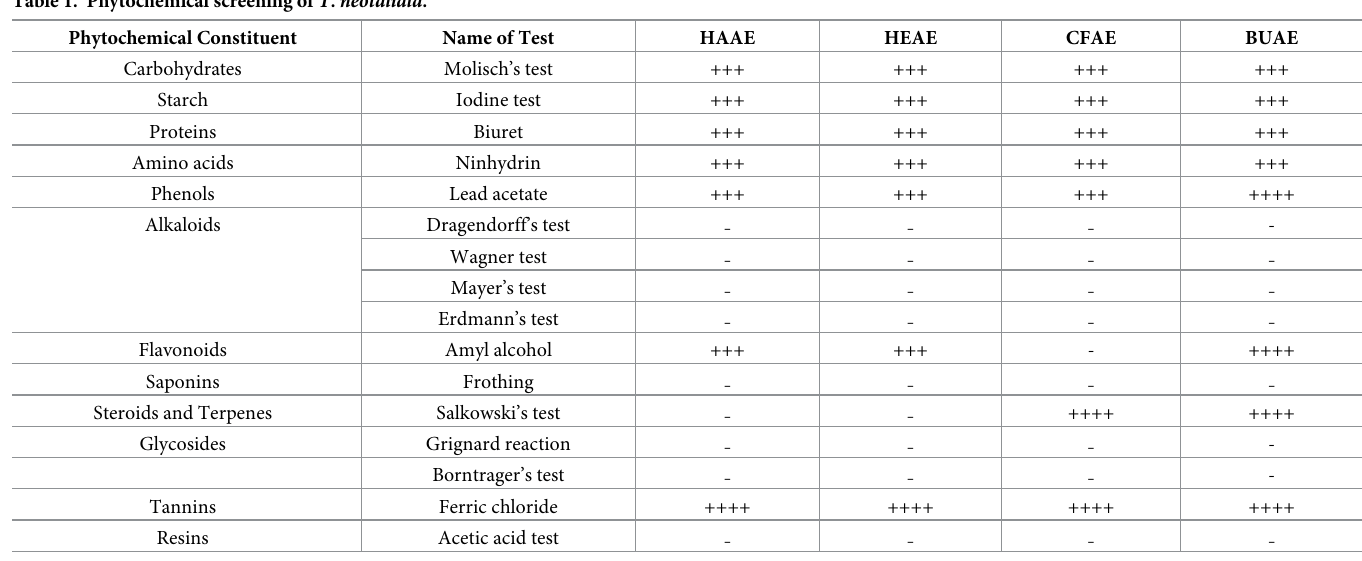
Table 1. Phytochemical screening of T . neotaliala .